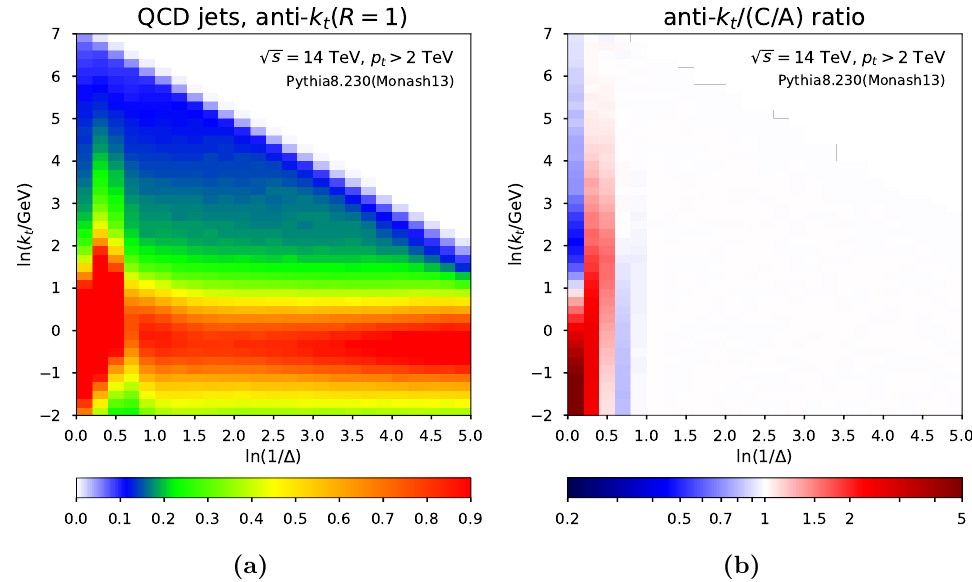
Figure 12. The averaged primary Lund plane density (a) for jets initially obtained with anti- k t clustering (whose constituents are then reclustered with the Cambridge/Aachen algorithm) and its ratio (b) to the averaged Lund plane density for jets originally obtained with Cambridge/Aachen clustering ((cid:12)gure 2). Note the structure around (cid:1) = 0 and ln k t = 0 that is present here and not in (cid:12)gure 2.